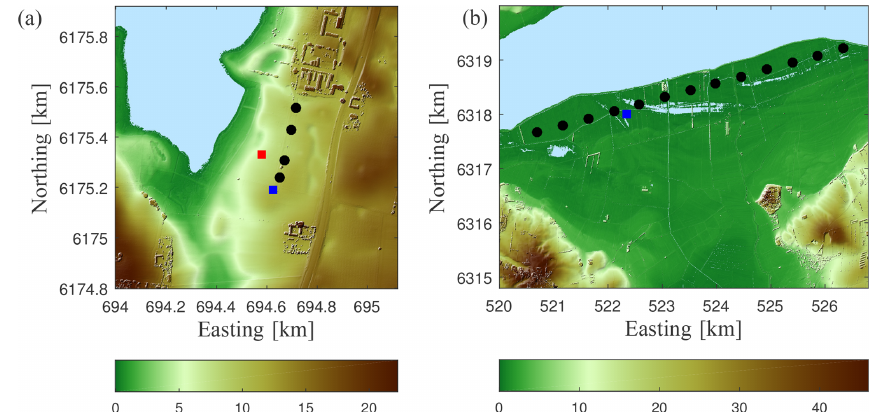
Figure 2. Locations of the sonic anemometer measurements. Wind turbines are indicated by black circles, masts with a CSAT3 by blue squares, and the mast with a USA-1 by a red square. Panel (a) shows the Risø test site and (b) the Nørrekær wind farm site. The color bar indicates the height above mean sea level in meters based on a digital surface elevation model (UTM32 WGS84). Table 1. Sonic anemometer specifications for each measurement site including the types of flow-distortion (FD) and/or path-averaging (PA) corrections applied. Due to the height of the instrument at Nørrekær Enge, we did not apply a PA correction as the error should be negligible. Site Sonic Height a.g.l. p Types of anemometer (m) (mm) correction none Risø USA-1 16.5 175 FD (M04) PA (H06) and FD (M04) none Risø CSAT3 6.4 115 FD(H15) PA (H06) and FD (H15) none Nørrekær Enge CSAT3 76.0 115 FD